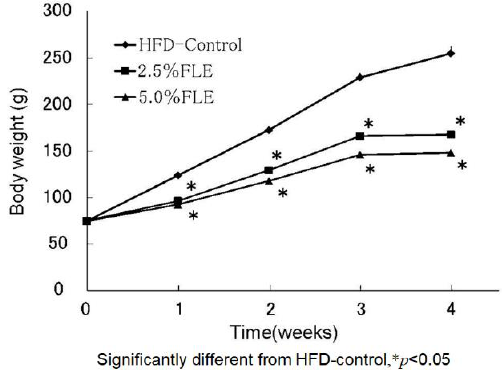
Figure 3. Effects of FLE on the body weight of rats.